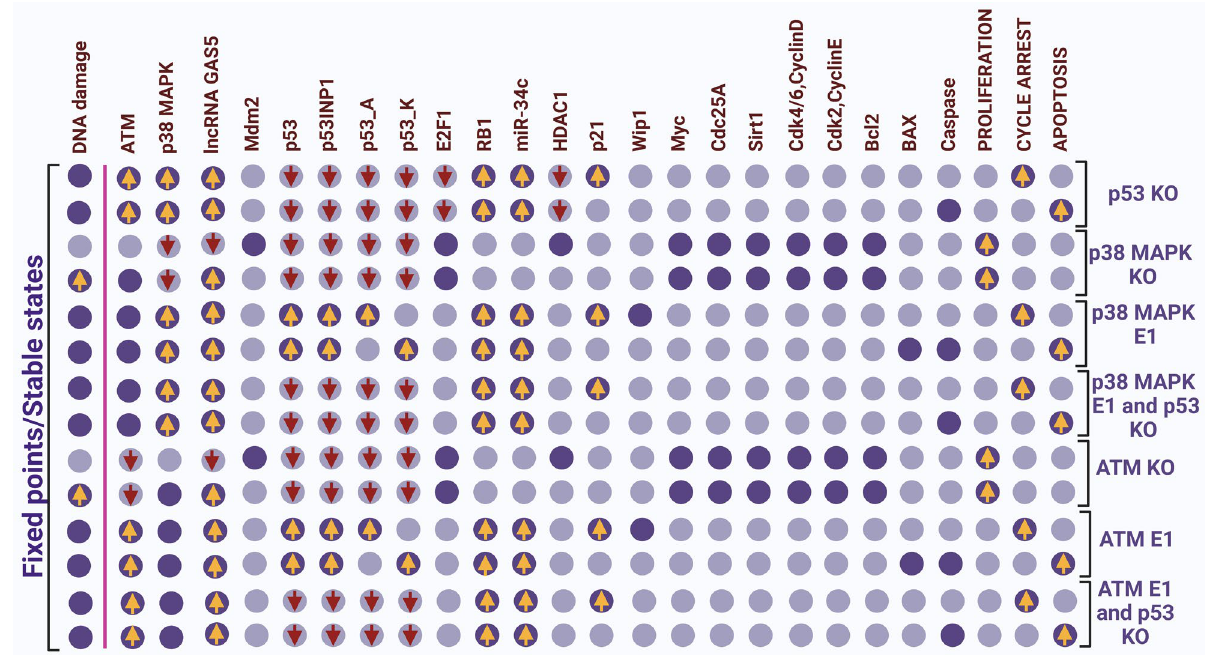
Figure 3. Interrogation of the ATM/p38 MAPK and p53 signaling pathway in GC. Ectopic expression (E1) represents gain-of-function (GoF) while knockdown (KO) represents loss-of-function (LoF) of the respective network element. The leftmost column shows the level of DNA damage with other molecules separated by a pink line. In contrast, the rightmost columns show the model outputs: proliferation, cell cycle arrest, and apoptosis. Each line represents a fixed point or steady state corresponding to the input. Light purple cells indicate a zero value (inactivation), while dark purple cells indicate activation (value 1). The first two fixed points are related to loss-of-function (LoF) of p53, that is, all node knockdown (KO) of p53. As you can see, only the ATM/p38 MAPK pathway is activated and triggers cell cycle arrest and apoptosis in response to DNA damage. The next two fixed points are described as loss-of-function (LoF) of p38 MAPK, that is, induction of proliferation. Apparently, the first fixed point knockdown (KO) of p38 MAPK represents a proliferation state due to the inactivation of DNA damage. Even in the presence of DNA damage, knockdown (KO) of p38 MAPK accelerated proliferation due to activation of cell cycle promoters such as E2F1, Myc, and CDK-cyclin complex. As you can see, loss-of-function (LoF) of p38 MAPK in response to DNA damage, lncRNA-GAS5 expression is accelerated but fails to trigger cell cycle arrest and/or apoptosis except in the proliferation state. After that, the other two fixed points represent the gain-of-function (GoF) of p38 MAPK, which means cell cycle arrest and apoptosis as well as activation of the p53 pathway. The ensuing fixed points are associated with gain-of-function (GoF) of p38 MAPK as well as loss-of-function of p53. Clearly, activation of the expression of the lncRNA-GAS5, miR-34c, p21, and RB1 triggers arrest and apoptosis (independently of p53). The other two following fixed points indicate the knockdown (KO) of ATM. Equally, this was observed in the loss-of-function (LoF) of p38MAPK. This means that at a certain point in the absence of DNA damage and another in response to DNA damage triggered proliferation; similarly, the lncRNA GAS was activated but refused to induce cell cycle arrest and apoptosis-like phenotypes. The other two fixed points of ATM represent the gain-of-function (GOF) of ATM, and then, more two fixed points (at last) represent the overexpression (E1) of ATM with p53 KO (knockdown), i.e., expression of the lncRNA-GAS5, miR-34c, p21, and RB1, induces cell cycle arrest and apoptosis (independently of p53). Yellow arrows represent upregulation, while the red arrows facing down represent downregulation,